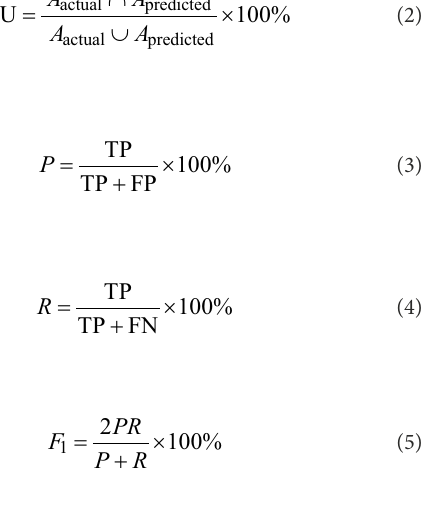
Figure 4 illustrates examples of the ResU-Net model identifying individual tree crowns at the study site. The accuracy of crown detection and delineation is shown in Table